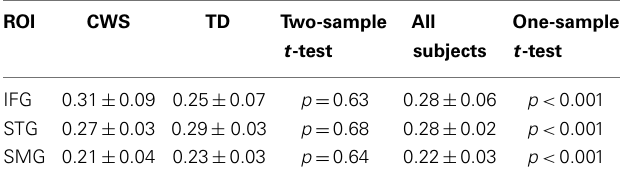
gyrus. Table 4 | Mean ( ± SEM) laterality indices (LI) for CWS andTD across three ROIs . ROI